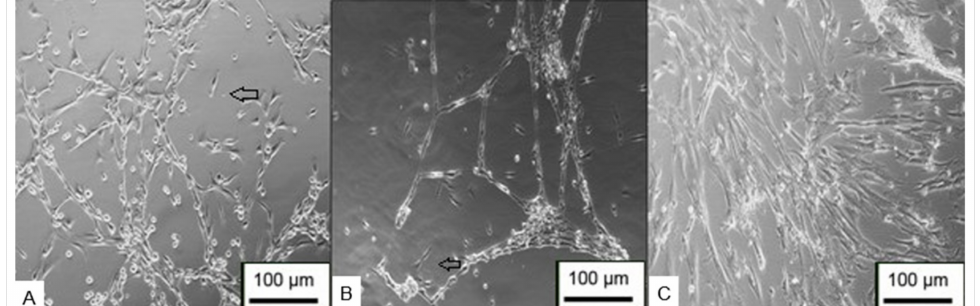
Figure 20. Differentiation in oligodendrocytes from Neural precursors. ( A ) Cells 4 days after induction; ( B ) 8 days after induction; ( C ) undifferentiated control (inverted optical microscopy— 100 × ). Scale bar, 100 µ m.